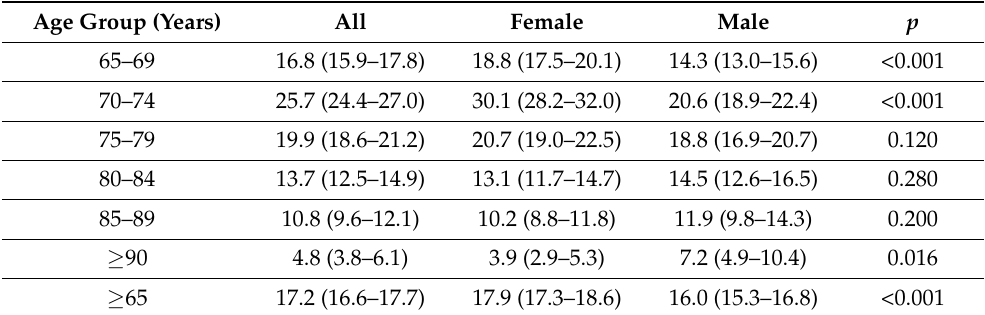
Table 2. Rates of screening according to age group and gender in the pooled population of 3 communities.